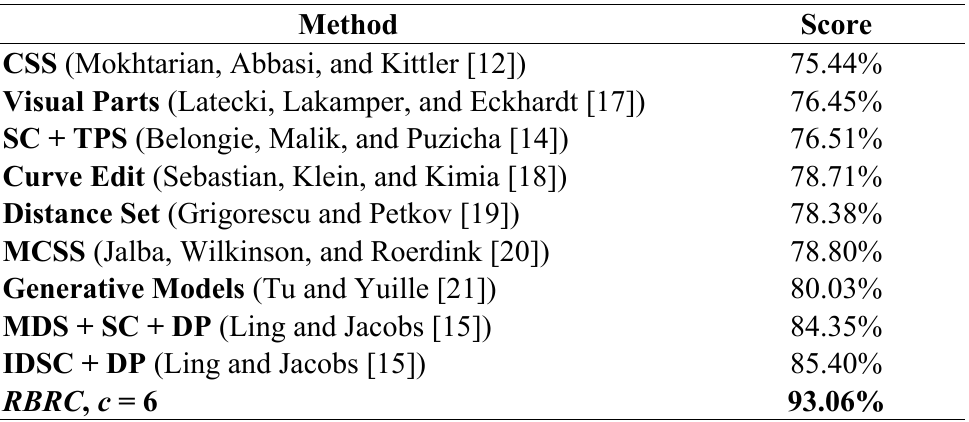
Table 1. Retrieval rate (bull’s eye measure, N = 40).